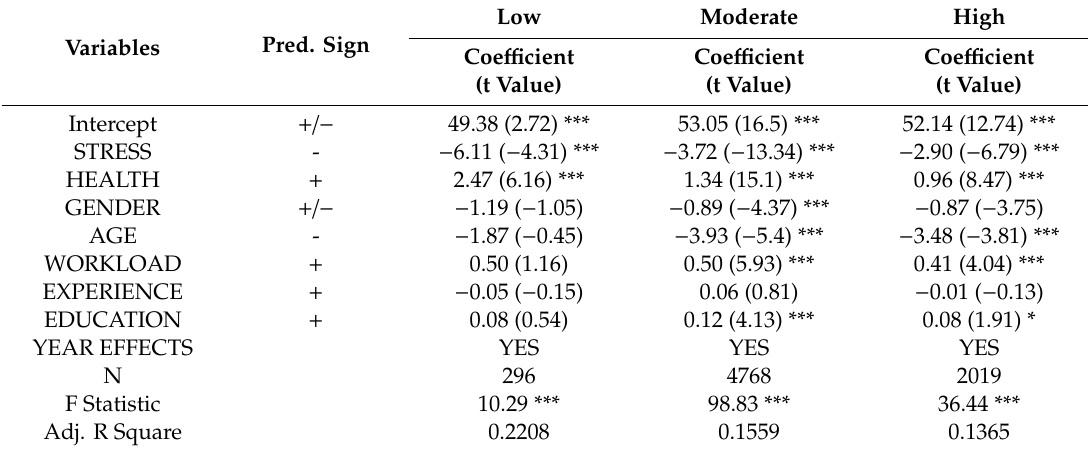
Table 6. Regression analysis of work ability in relation to subjective social